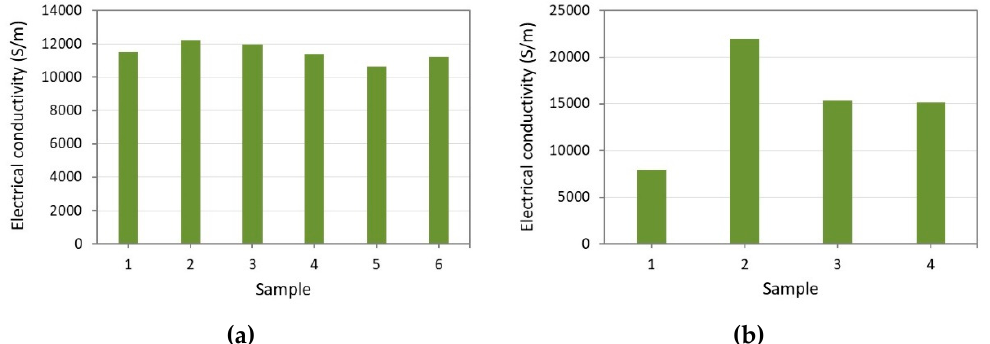
Figure 6. Electrical conductivity values of bio-composites: (a) CF-Rosin; (b) CF-Flax/Epoxy.